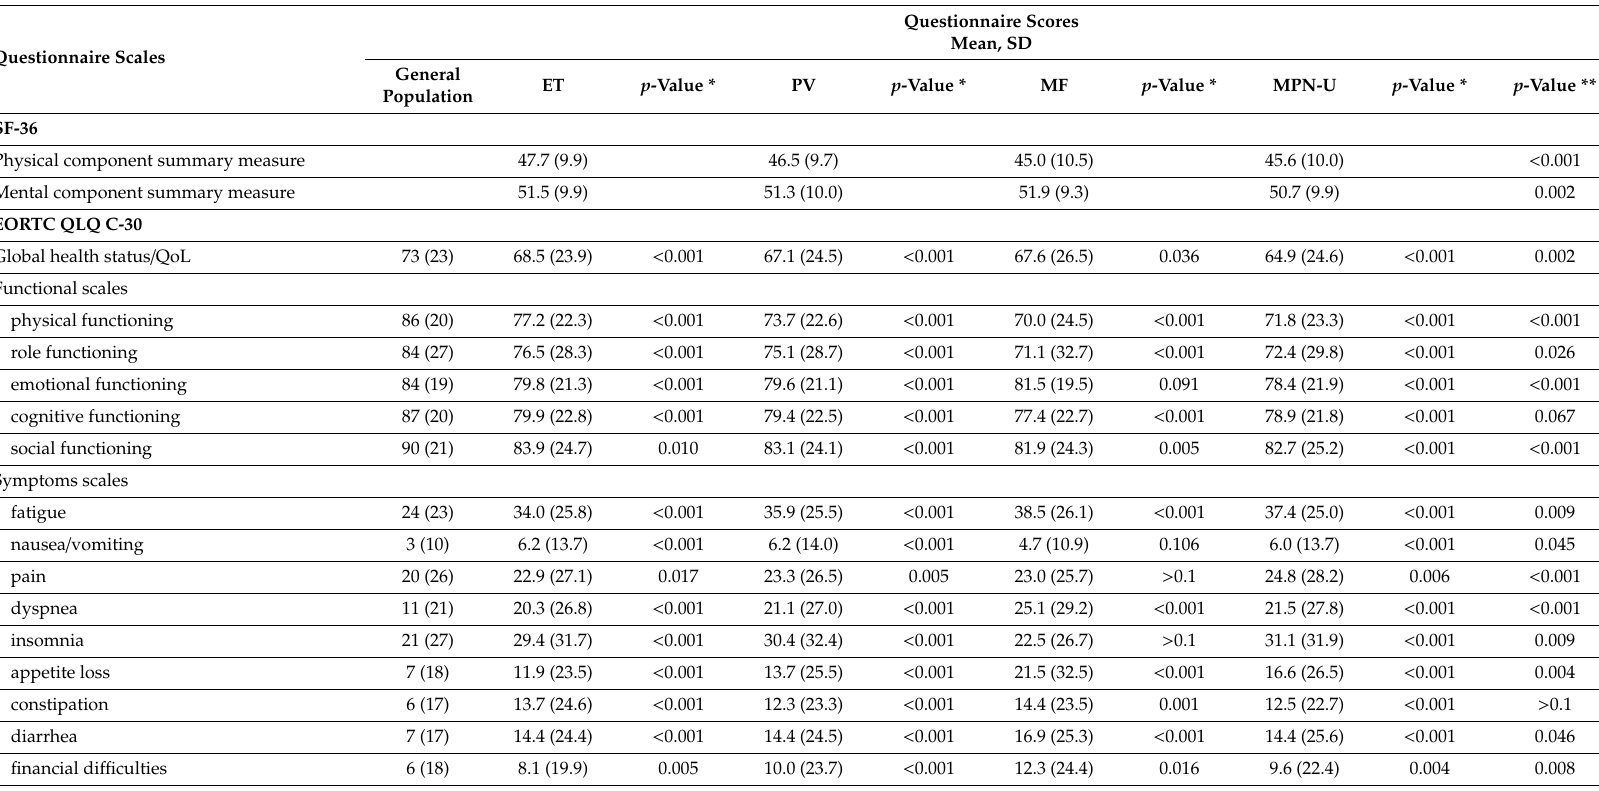
Table 2. Di ff erences in health-related quality of life (HRQoL) between participants with di ff erent MPN subtypes and di ff erences in HRQoL between participants and the general